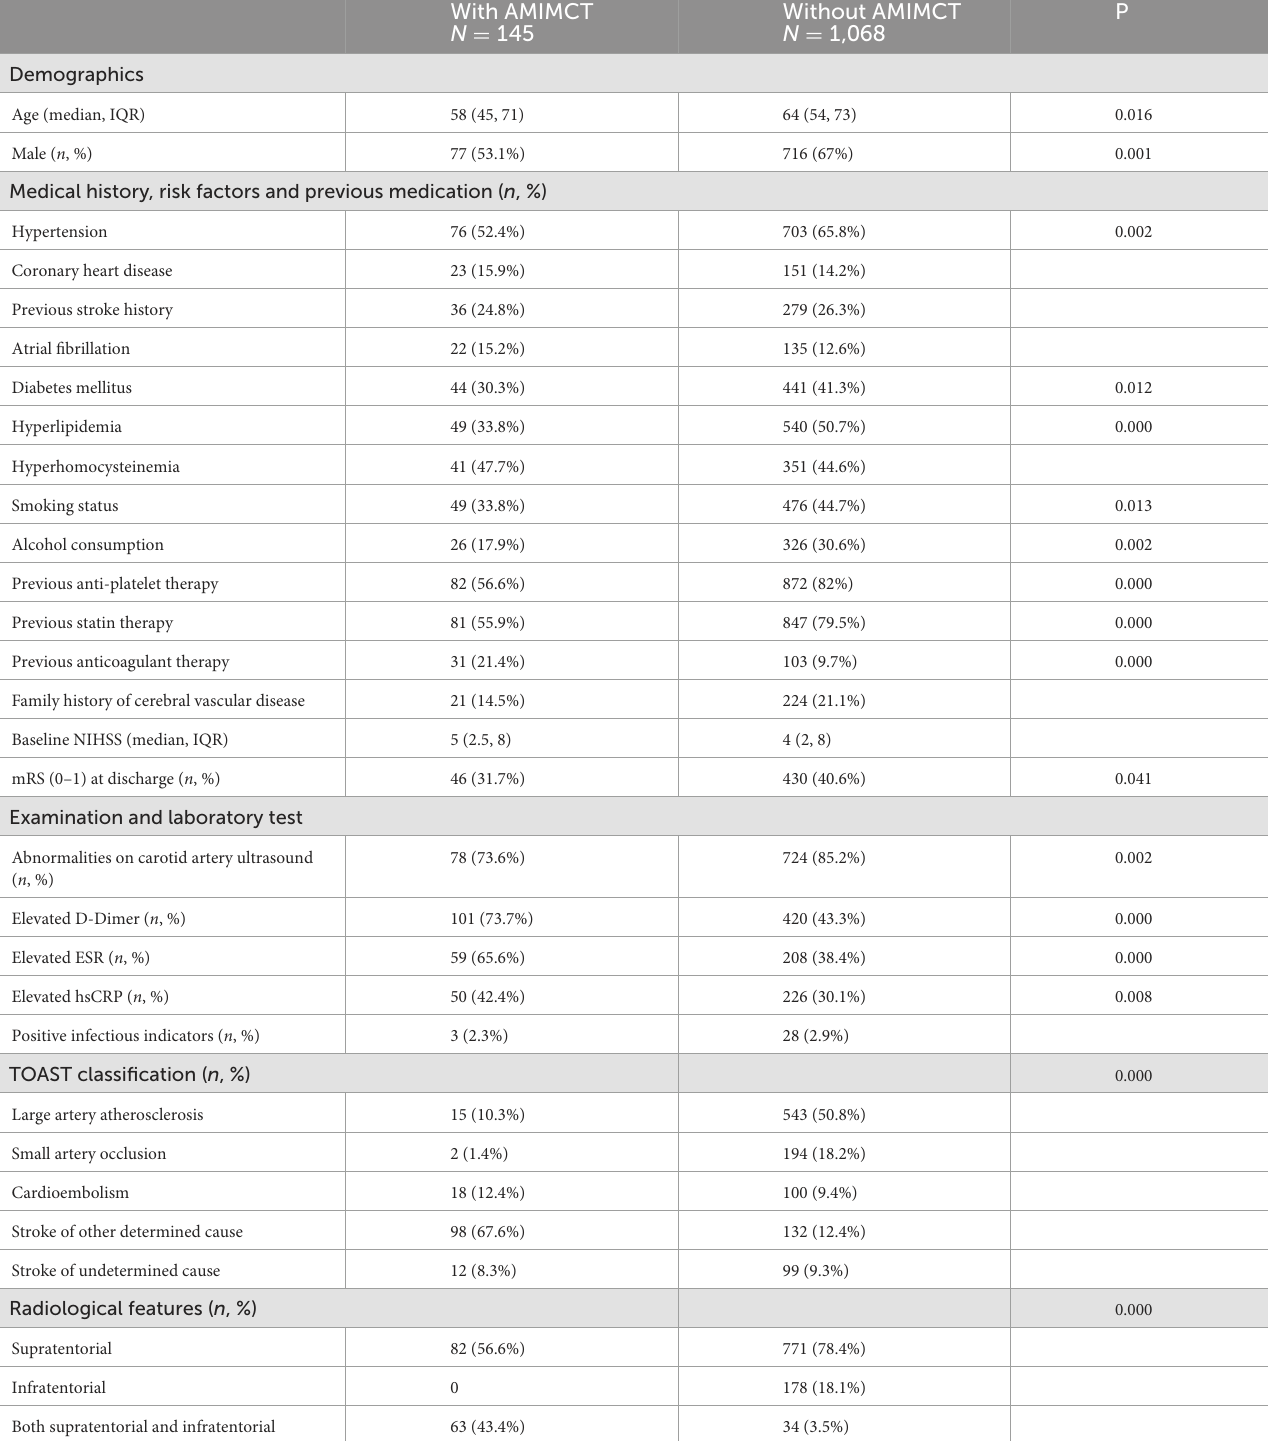
TABLE 1 Baseline characteristics of patients with and without